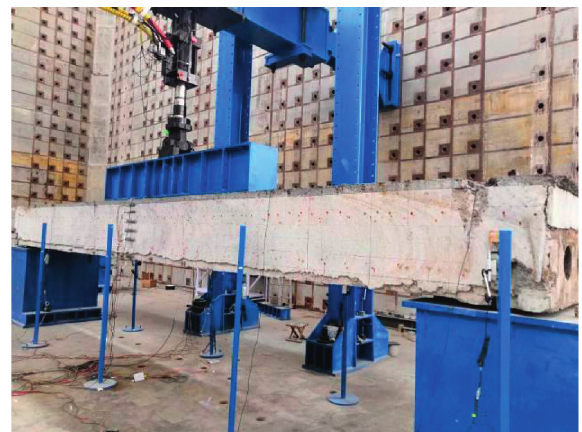
Figure 6: Overview of JD1 test setup.